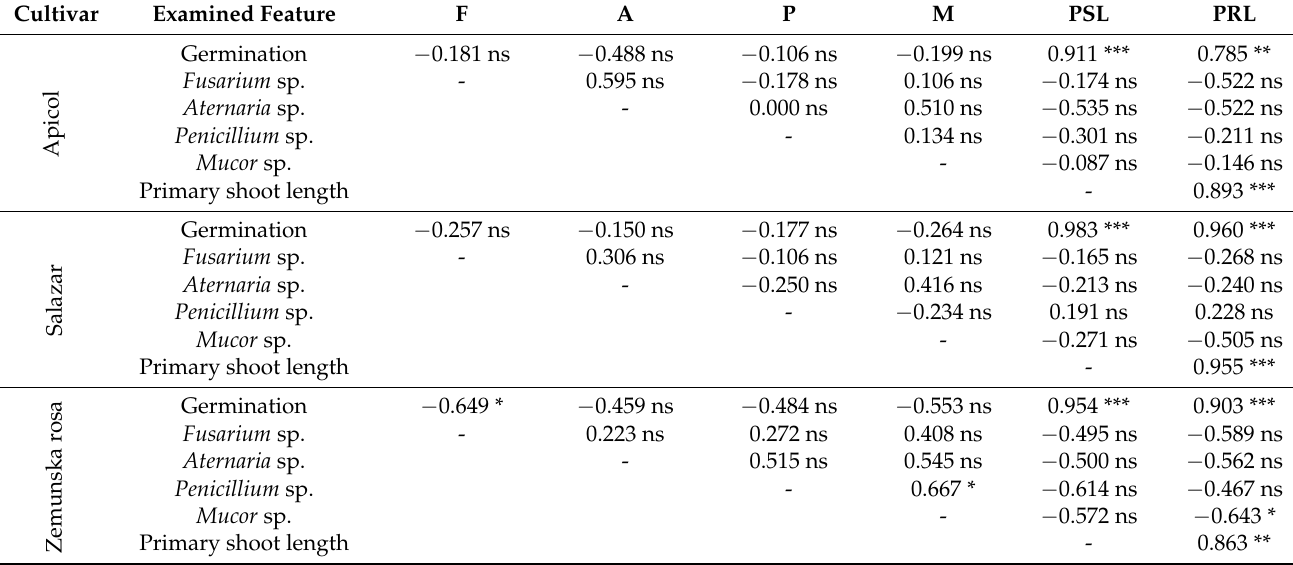
Table 11. Correlation dependence (r) between the germination and other examined parameters in three wheat cultivars ( n =